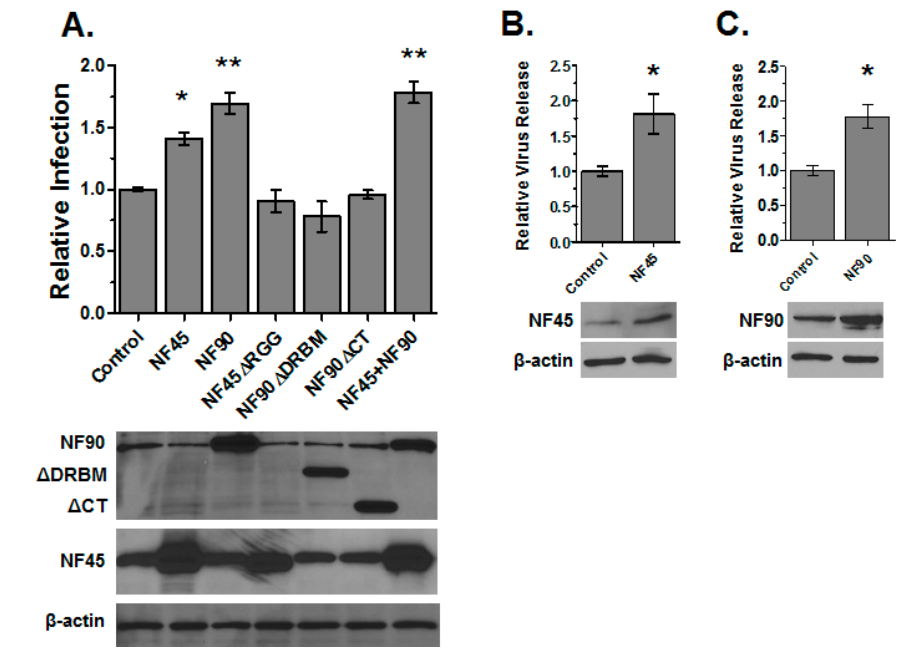
Figure 2. NF45 and NF90 potentiate human immunodeficiency virus (HIV) infection. ( A ) 293T cells